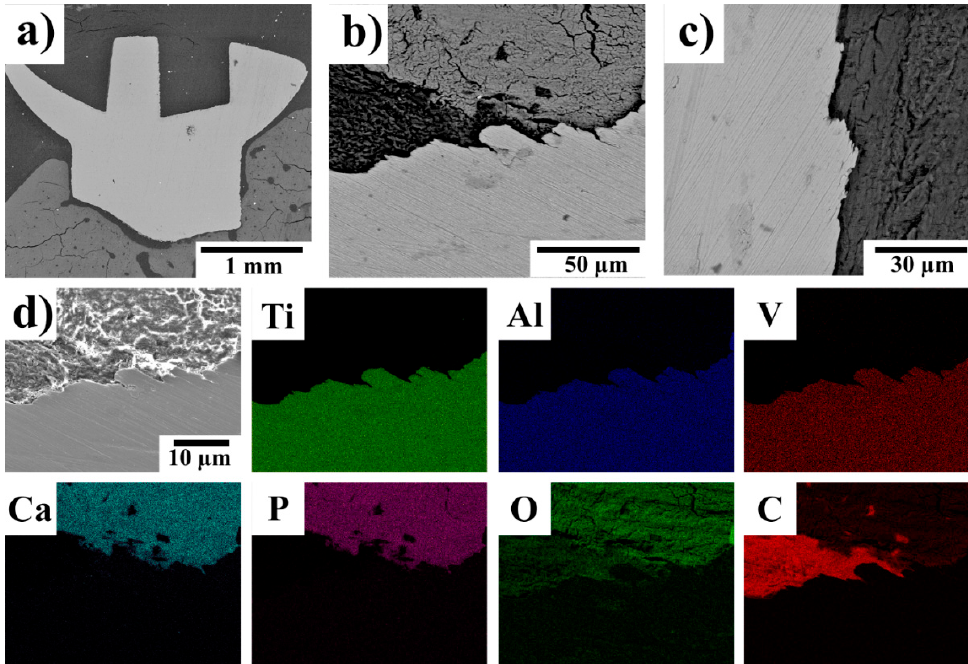
Figure 6. ( a – d ) SEM micrographs (Z-contrast) of a Ti-based control screw 360 days after implantation in rabbit tibias. The X-ray elemental maps showing the distributions of Ti, Al, V, Ca, P, O, and C were acquired from the area shown in ( d ); the scale bar is the same as in ( d ). In ( b , c ), the gray shaded areas can be interpreted as follows: the lightest gray—metallic implant, dark gray—bone tissue and black/the darkest gray—fibrous tissue.